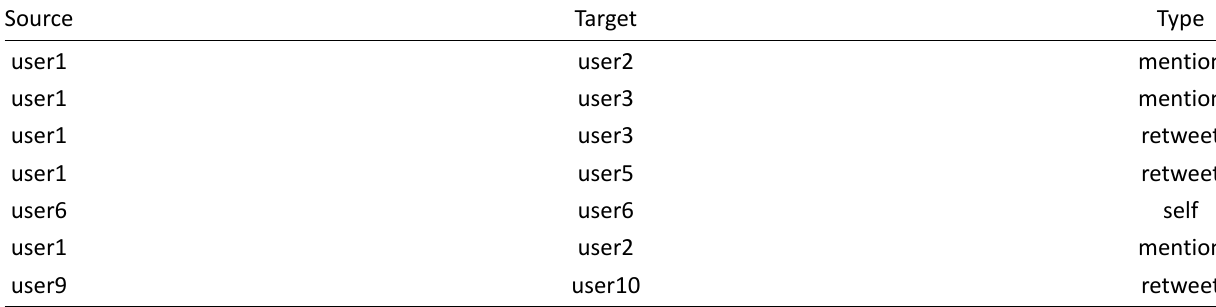
Table 3. Interactions between users.